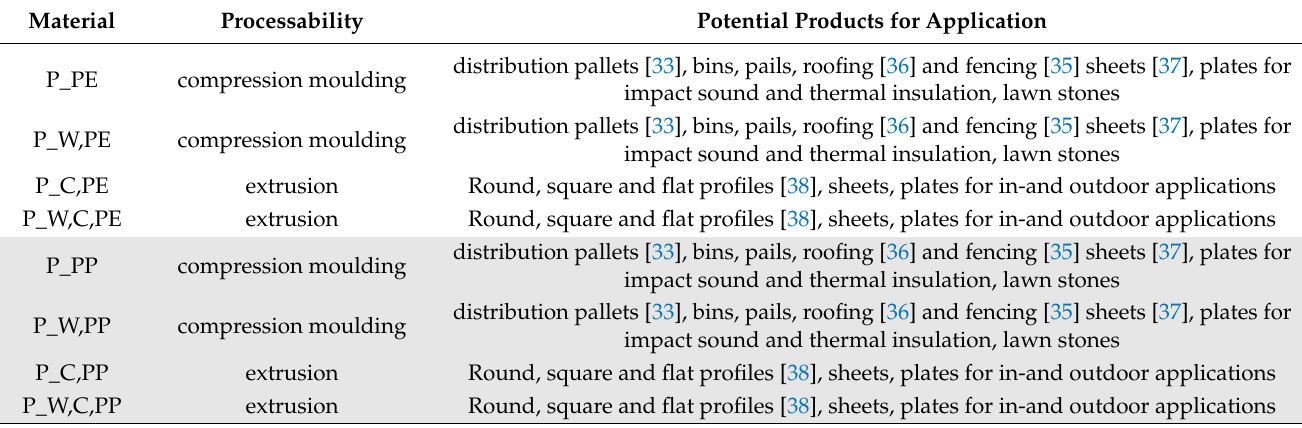
Table A53. Possible applications for the materials